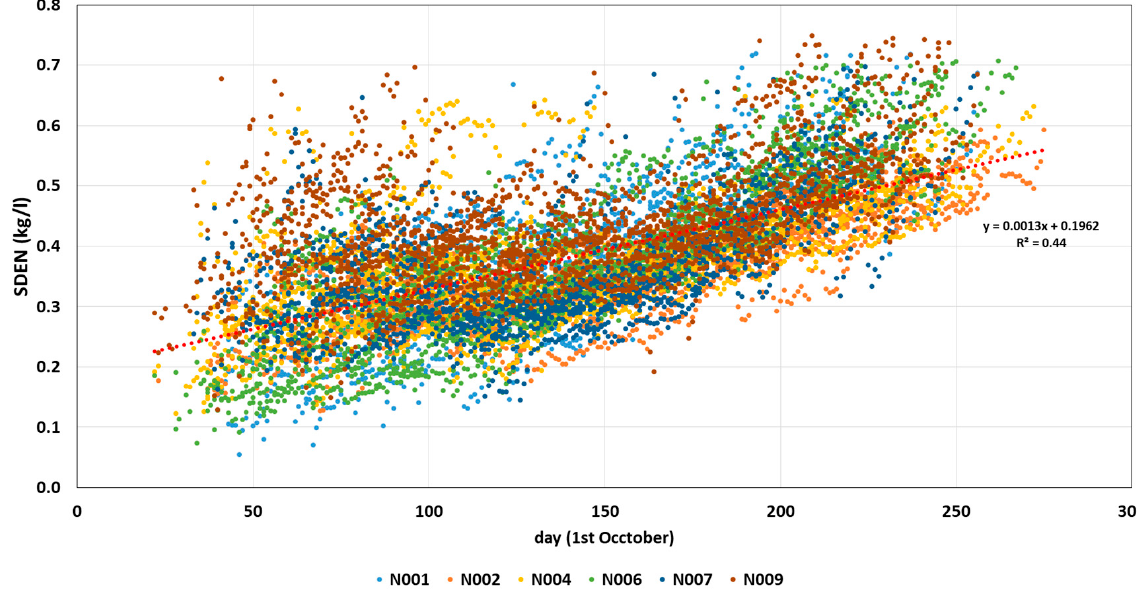
Figure 6. SDEN intra-annual time dependence for selected TNM measurements. Red trend line for the set of TNMs .